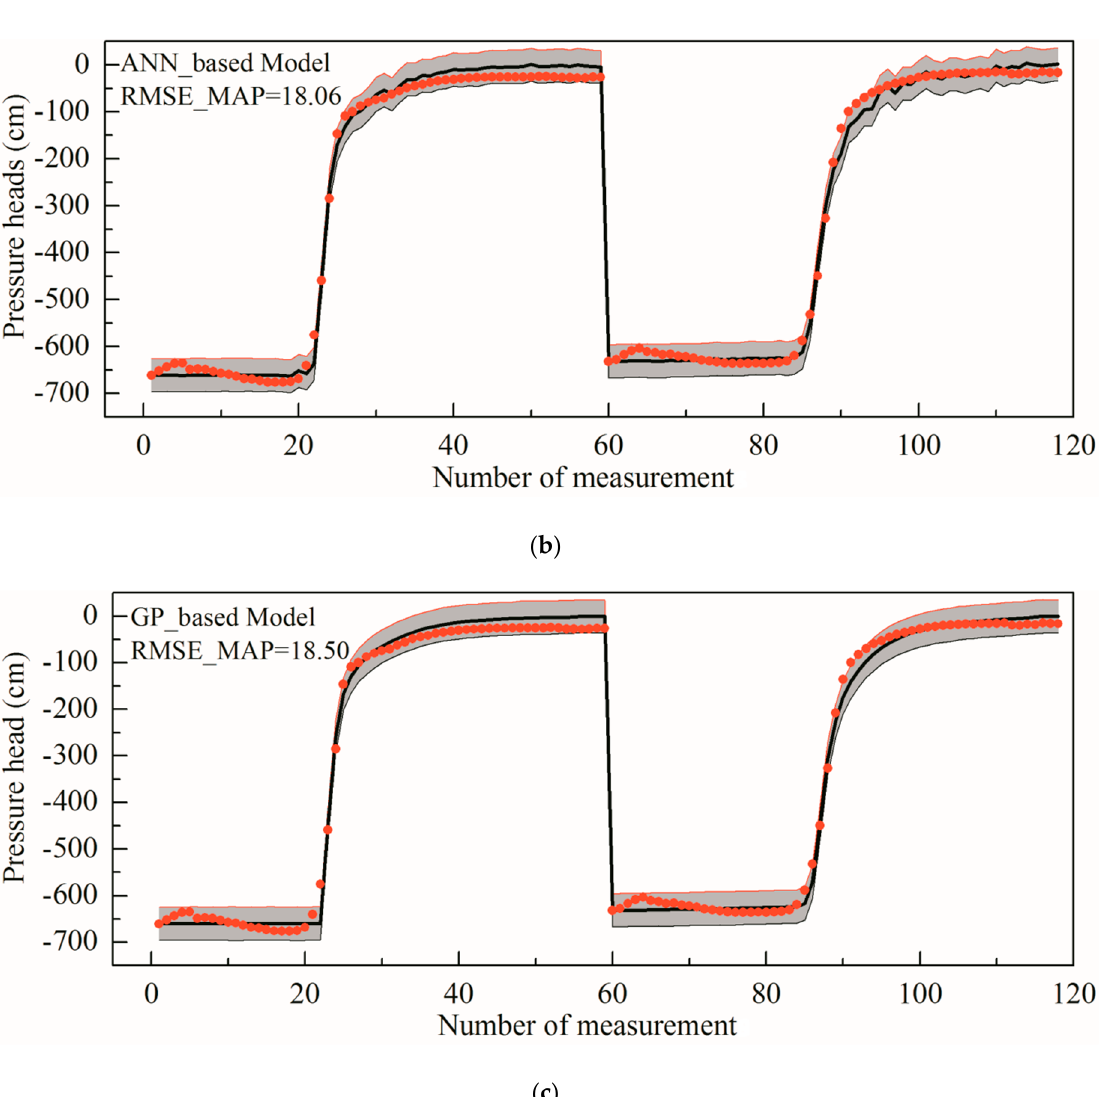
Figure 6. Results for the field irrigation experiment. The red dots are the 75 pressure head measurement values and the grey areas are the 95% confidence intervals of the MCMC simulation results. The solid lines denote the simulated results using the posterior MAP parameters. ( a ) Results based on Hydrus-1D model ( b ) Results based on ANN model ( c ) Results based on GP model